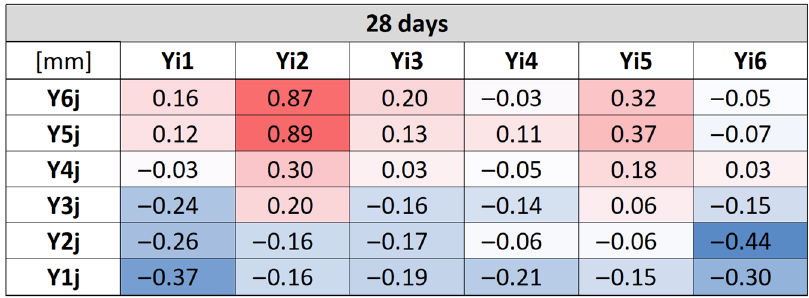
Figure 17. Dimensional changes in the Y ‐ axis of the wall element in the matrix (height level, vertical section) over 28 days (based on local measurements with Caliper functions).